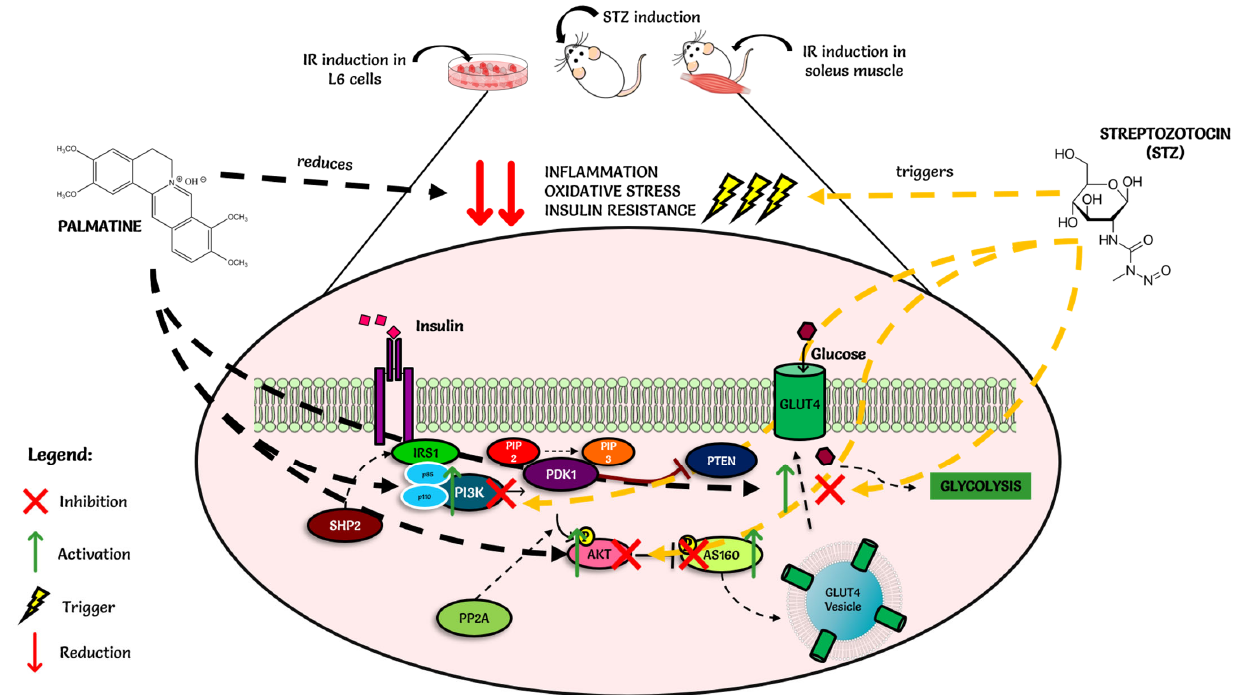
Figure 8. Schematic diagram of the mechanisms of action of palmatine.